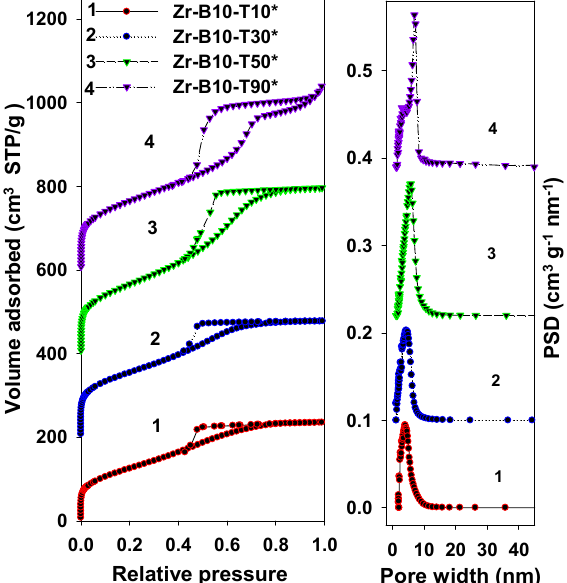
Figure 4. N 2 ‐ adsorption isotherms ( left panel ) and corresponding PSD curves ( right panel ) for Zr ‐ B10 ‐ TX*; isotherms are shifted by a multiple of 200 cm 3 STP/g. PSD curves 2, 3, and 4 are shifted by